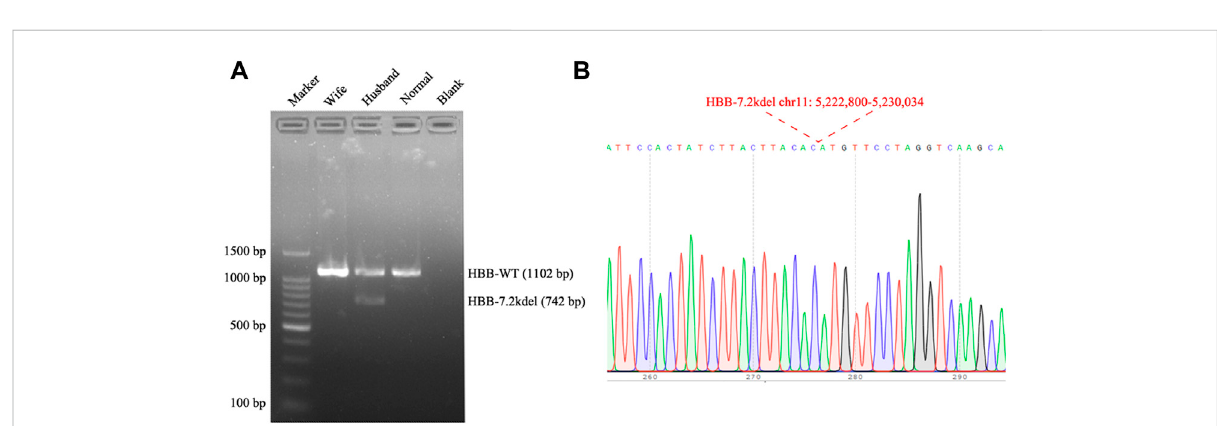
FIGURE 3 Gap PCR and Sanger sequencing results. (A) Gap PCR and agarose gel electrophoresis were performed to detect the deletion breakpoint. With theprimers(7.2 Kbdeletionforwardprimer:5 ′ -ATTTCTCCCTTGATAGTTTCTACTTTGGGTT-3 ′ ,WildTypeforwardprimer:5 ′ -TACCATCATCCTGGC TTCAAGGC-3 ′ and the common reverseprimer: 5 ′ -ATCTGAAGACTGTACCTCTGCTCTCC-3 ′ ), an unique fragment about 742 bp in length was only ampli fi ed in the husband (Normal: Normal individual; Blank: Water). (B) The fragment was then sequenced, the breakpoint was accordant with the TGS